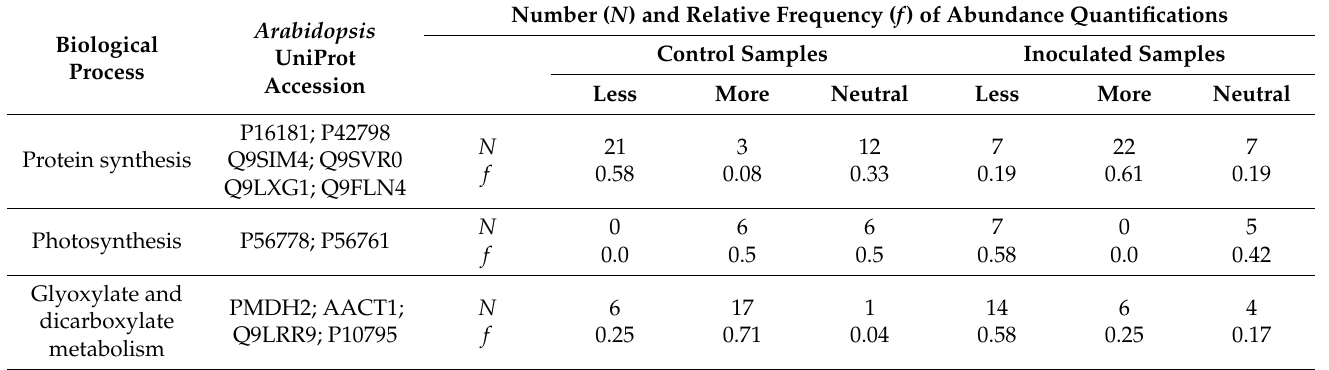
Table 5. Biological processes that stand out from the S-R3 solution in the cover problem